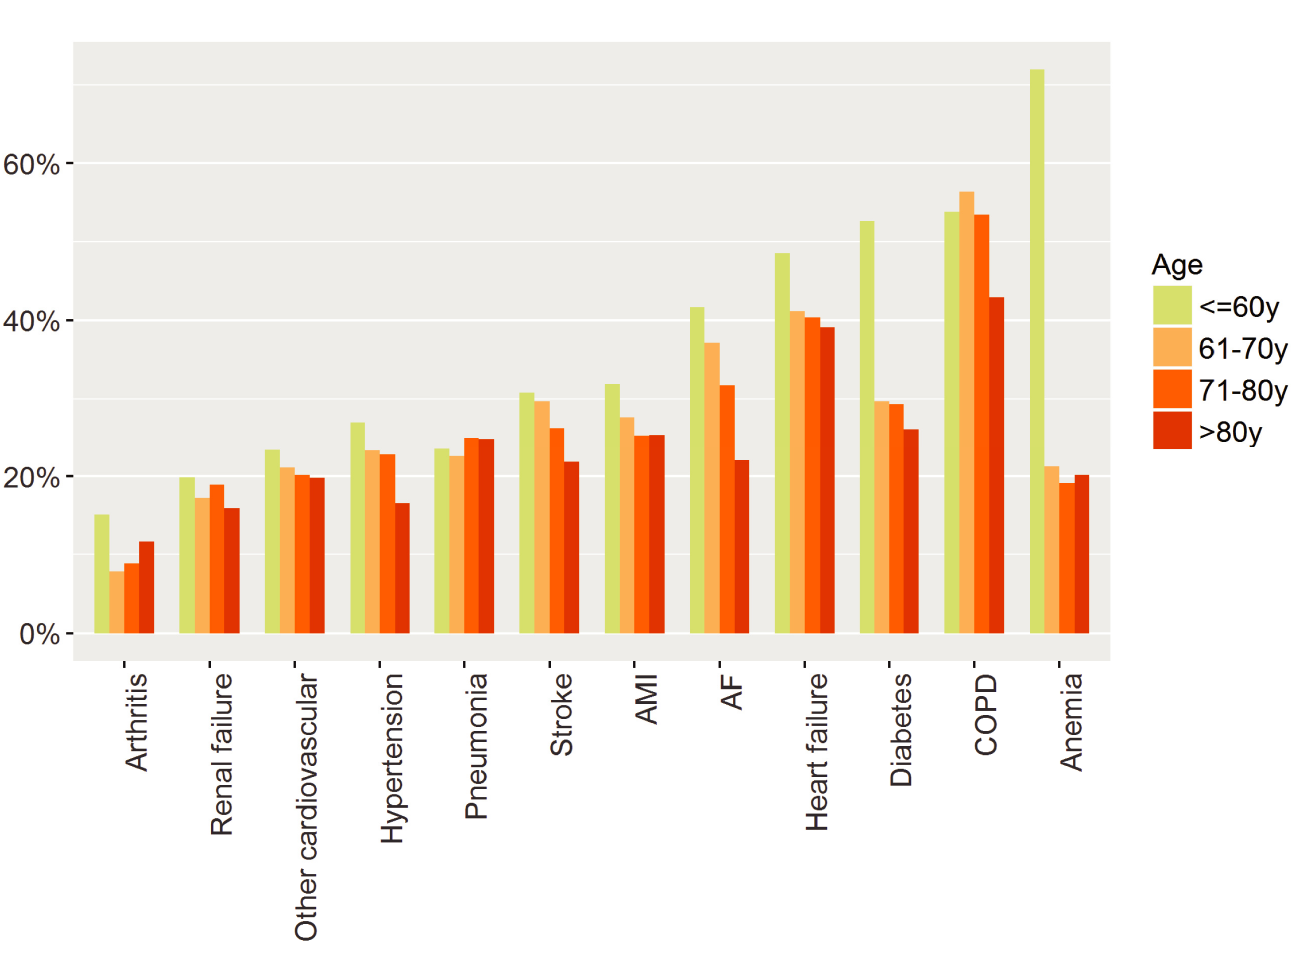
Fig 7. Readmission rates with the same condition by age for each of the chronic conditions. Abbreviations: AF atrial fibrillation; AMI acute myocardial infarction; COPD chronic obstructive pulmonary disease.